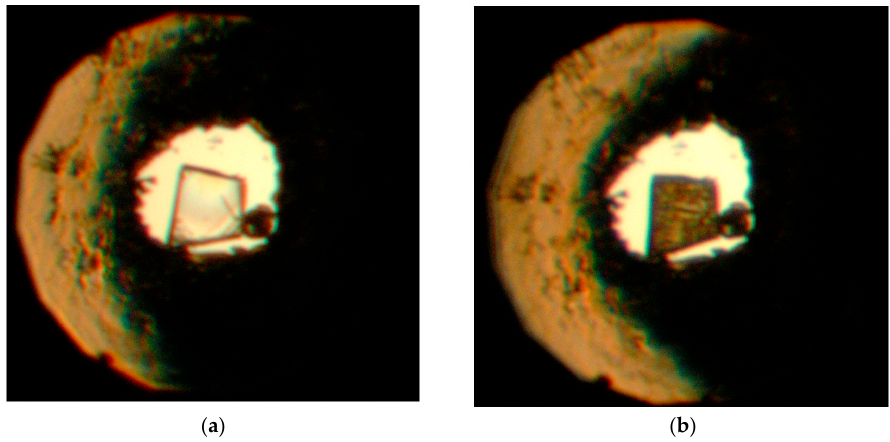
Figure 3. Visible changes in a melamine crystal before ( a ) and after ( b ) the irreversible high-pressure amorphization at 45 GPa in helium.